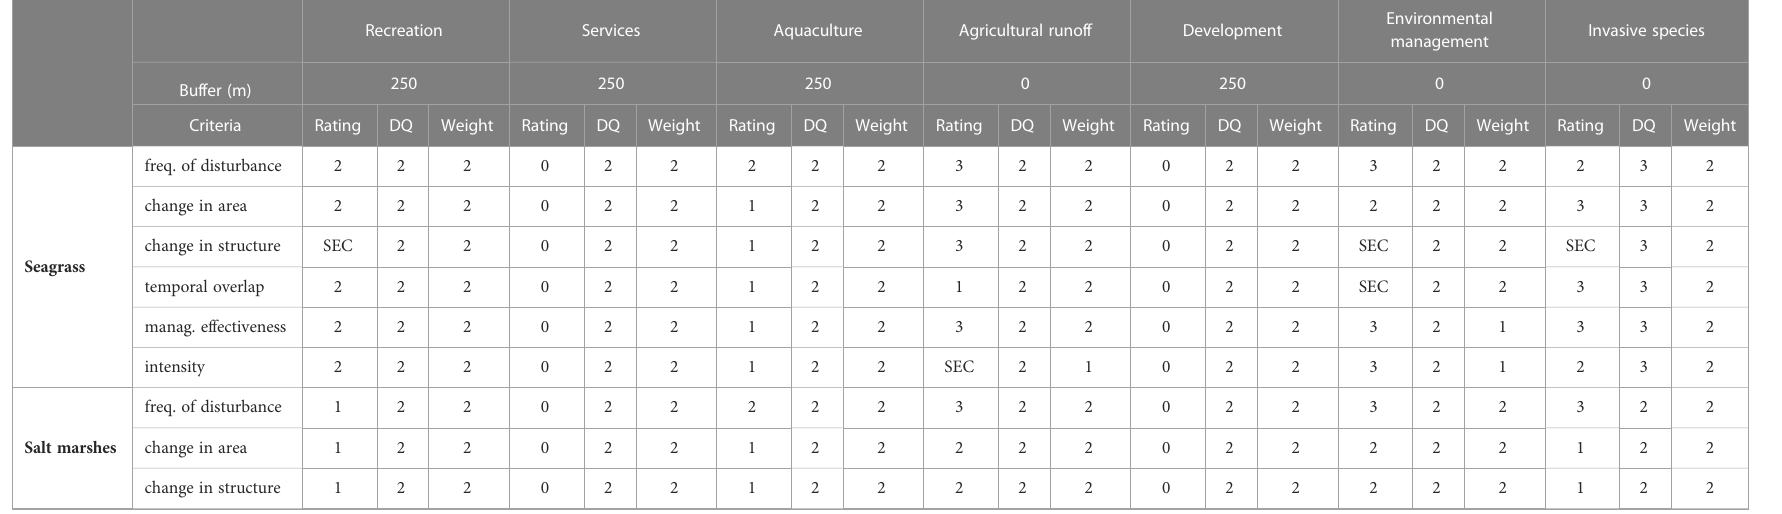
TABLE 4B Rating of exposure and consequence (sensitivity) criteria for the cumulative risk calculation given each habitat and human activity.